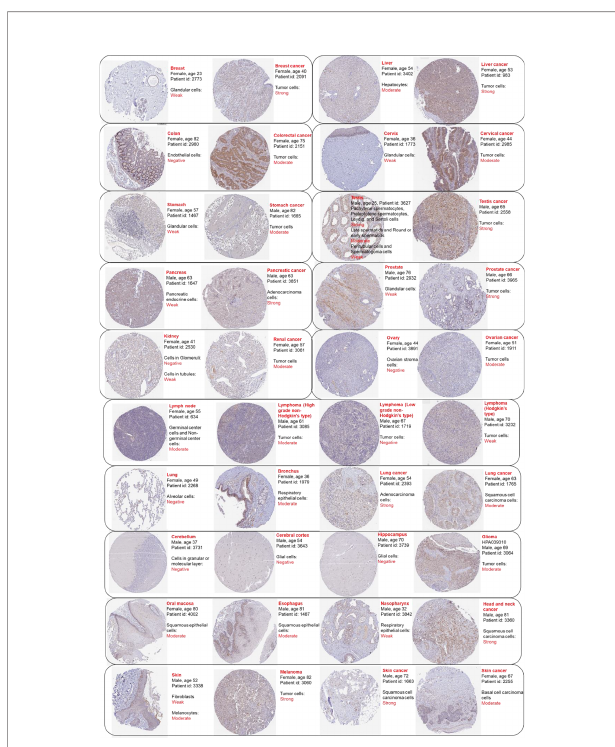
FIGURE 3 | Representative protein staining images of RAD51 in cancer and normal tissues. The images were downloaded from the Human Protein Atlas (HPA). Antibody HPA039310 was used to stain RAD51 except for stomach and stomach cancer (antibody CAB010381). The sample details and the general pathological results were provided by